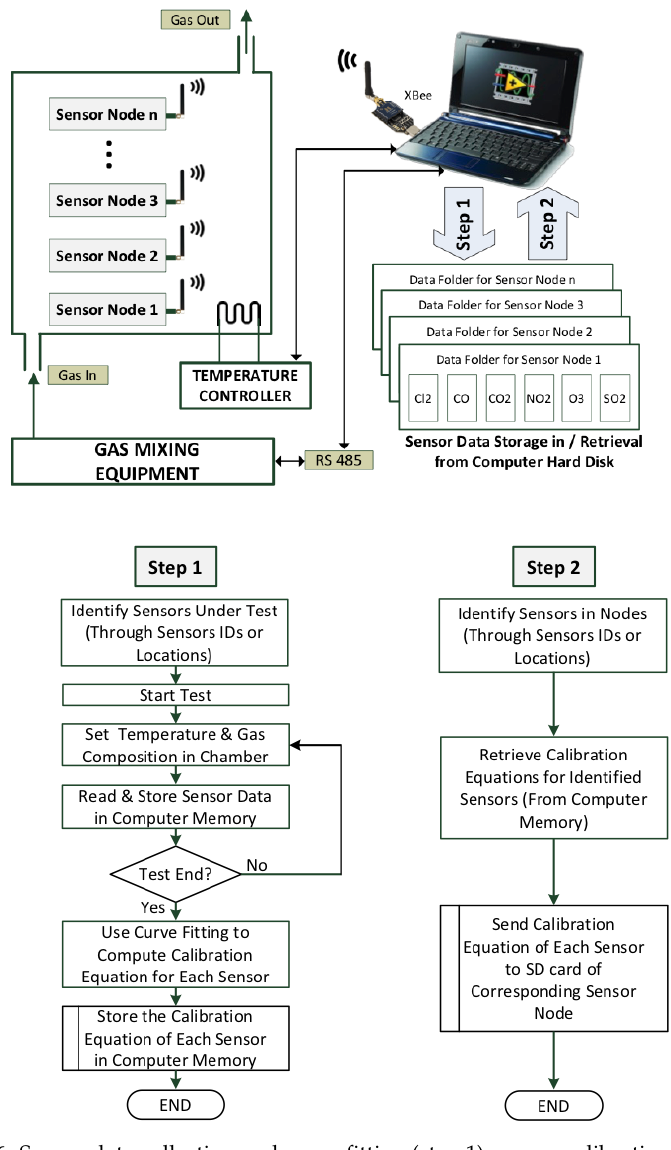
Figure 6. Sensor data collection and curve fitting (step 1); sensor calibration (step 2).